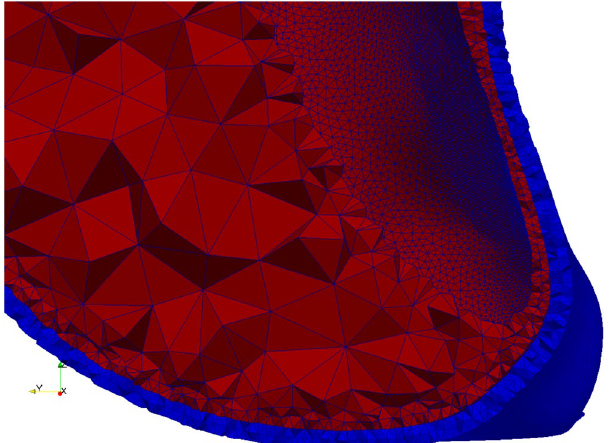
Figure 13. Example of meshing. The AAA wall is meshed using 2 layers of elements (configurable). The ILT is meshed using a minimum of 2 layers of elements (configurable); the element size is increased in the middle of the ILT layer to reduce the number of elements in the